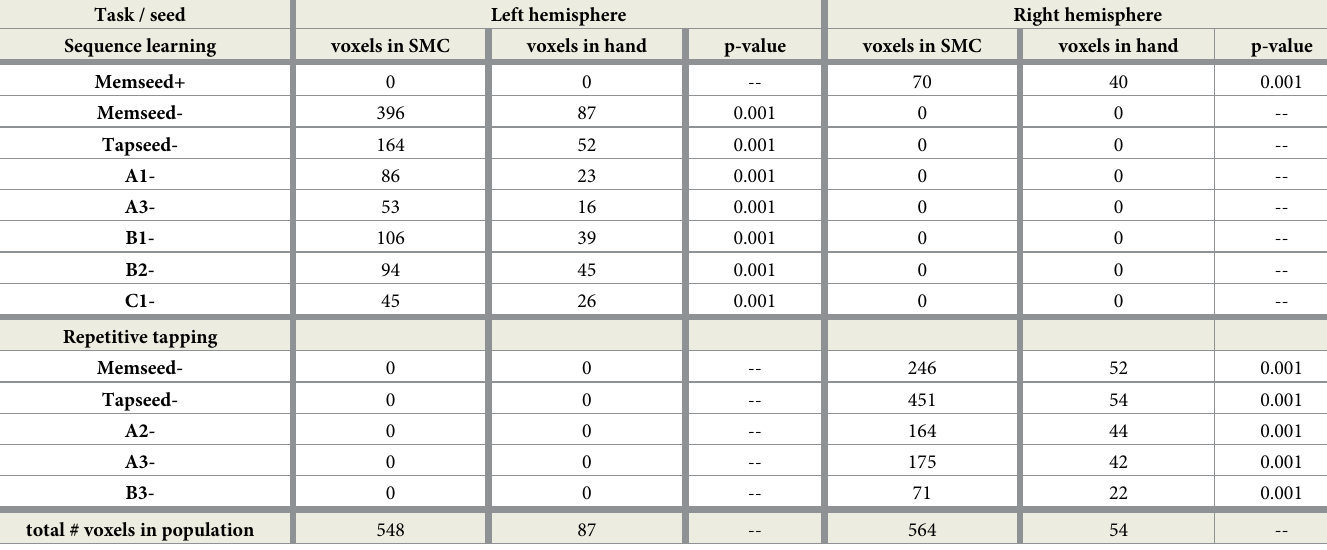
For each seed, connectivity was significantly limited to the hand representation; the number of voxels showing connectivity within the SMC and hand representation are reported for each hemisphere. Levels of significance were identified from the hypergeometric